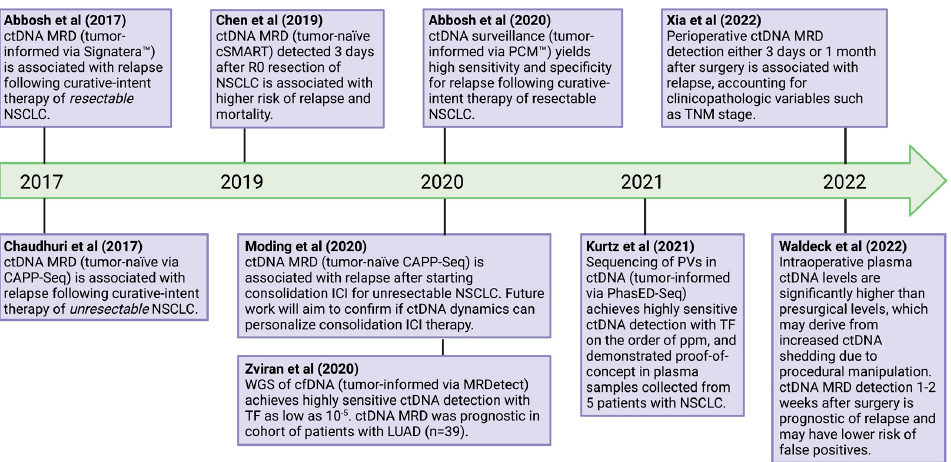
Figure 2. Timeline of ctDNA MRD studies in patients with NSCLC. A timeline of studies that have advanced our understanding of ctDNA MRD as a prognostic and potentially predictive biomarker in patients with NSCLC, who were treated with a curative-intent [39,115–122].